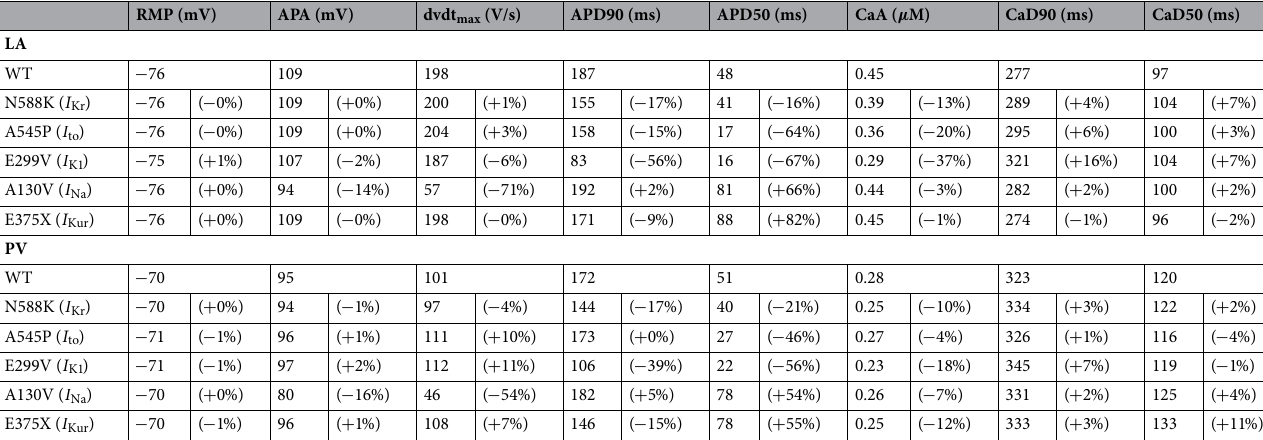
Table 5. Comparisons between computed WT and mutant biomarker values for simulations of the LA and PV versions of the membrane model driven at 1 Hz. These comparisons are based on changes in the same biomarkers as in Table 4, which are defined in the “Defining biomarkers” section. The numbers in parentheses report the deviation from WT. Note that the c.932delC mutation (in connexin 43) is not included here because these biomarkers are computed from simulations of the single myocyte LA and PV membrane models, and the c.932delC mutation does not affect any of the parameters of the membrane